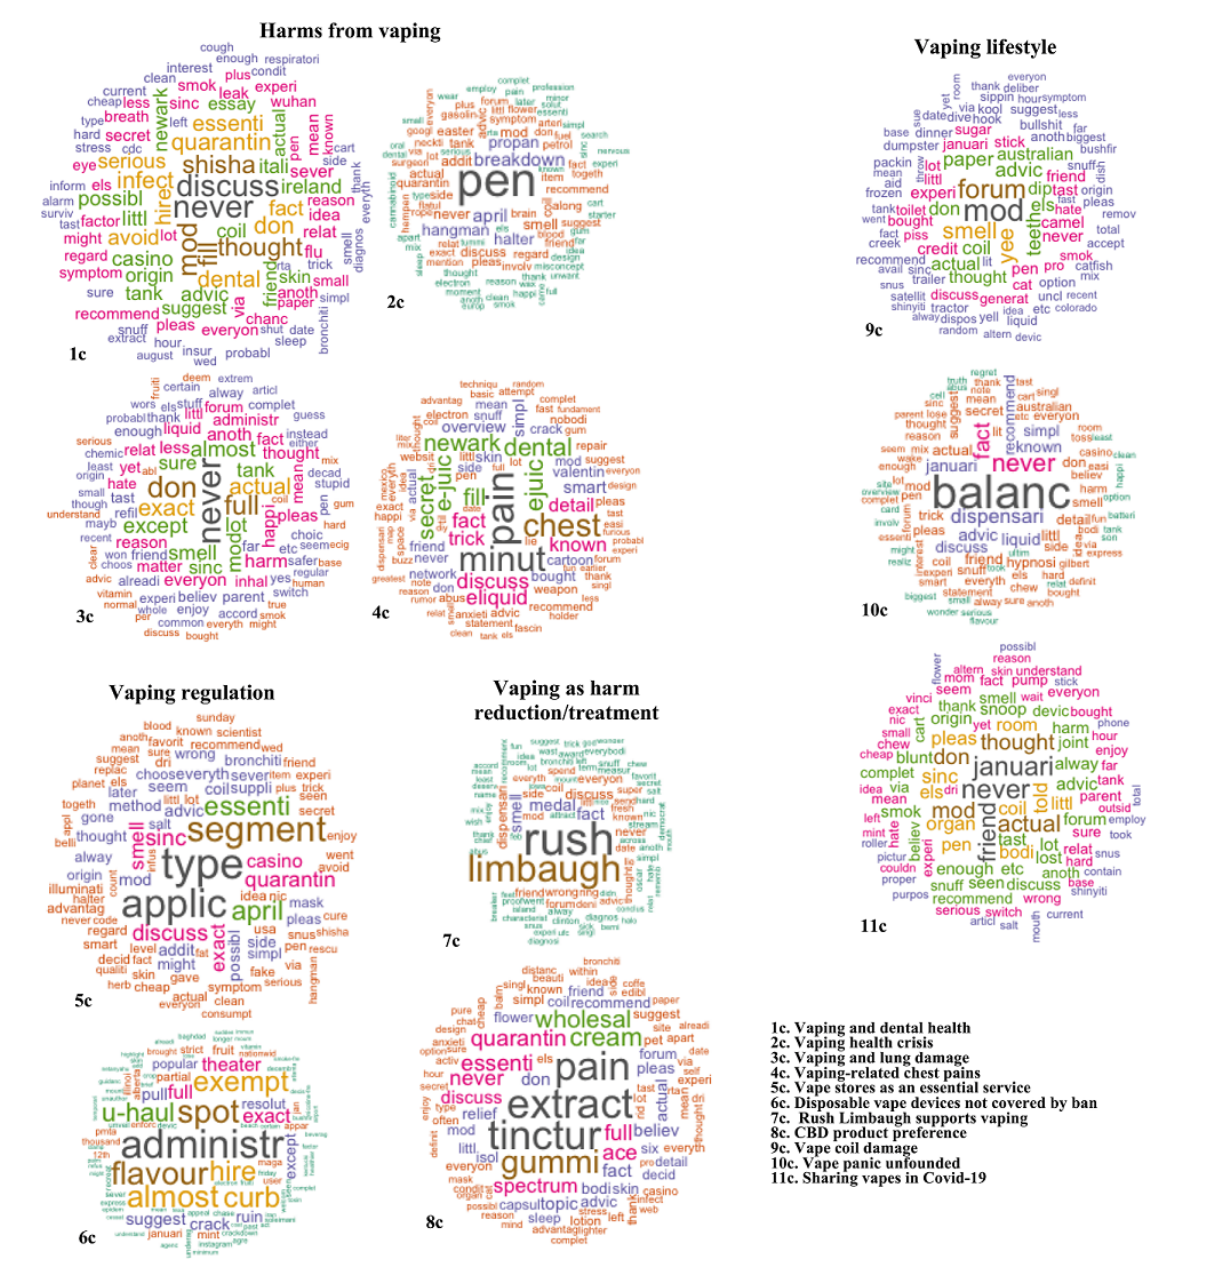
Figure 4. Major archetypes of vaping-related topics with example topics per archetype obtained by structural topic modeling after COVID-19 was reported to the WHO (January 1 to April 21, 2020). The word clouds are generated from the weights of the top 100 terms within a topic. Terms with larger weights are depicted in larger font sizes. Terms with approximately the same weight are depicted in the same